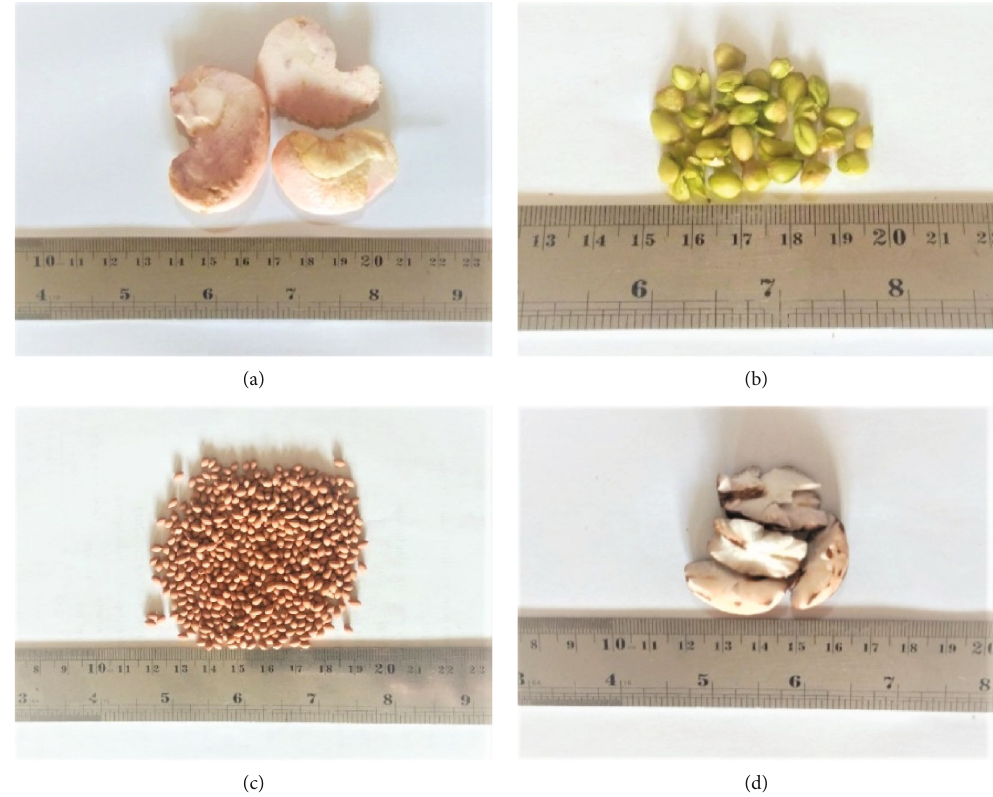
Figure 1: Fruit seed kernels: (a) mango, (b) sweet orange, (c) papaya, and (d) snake